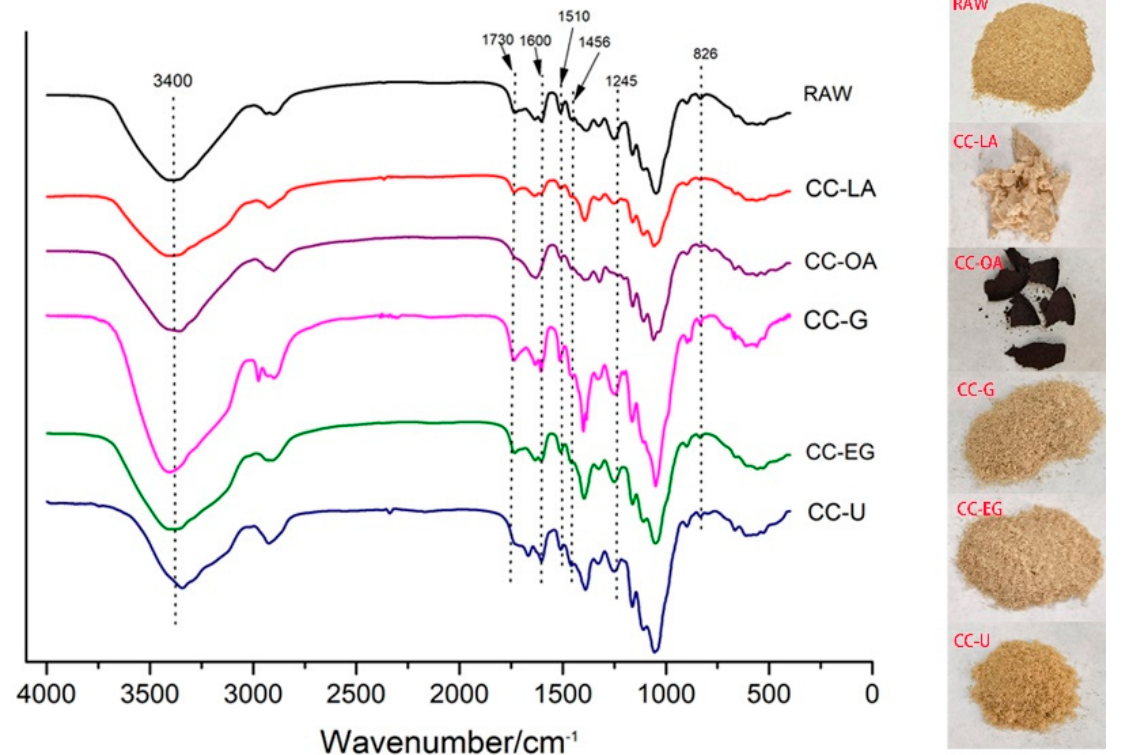
Figure 4. FTIR spectra and images of bagasse treated with different DESs.